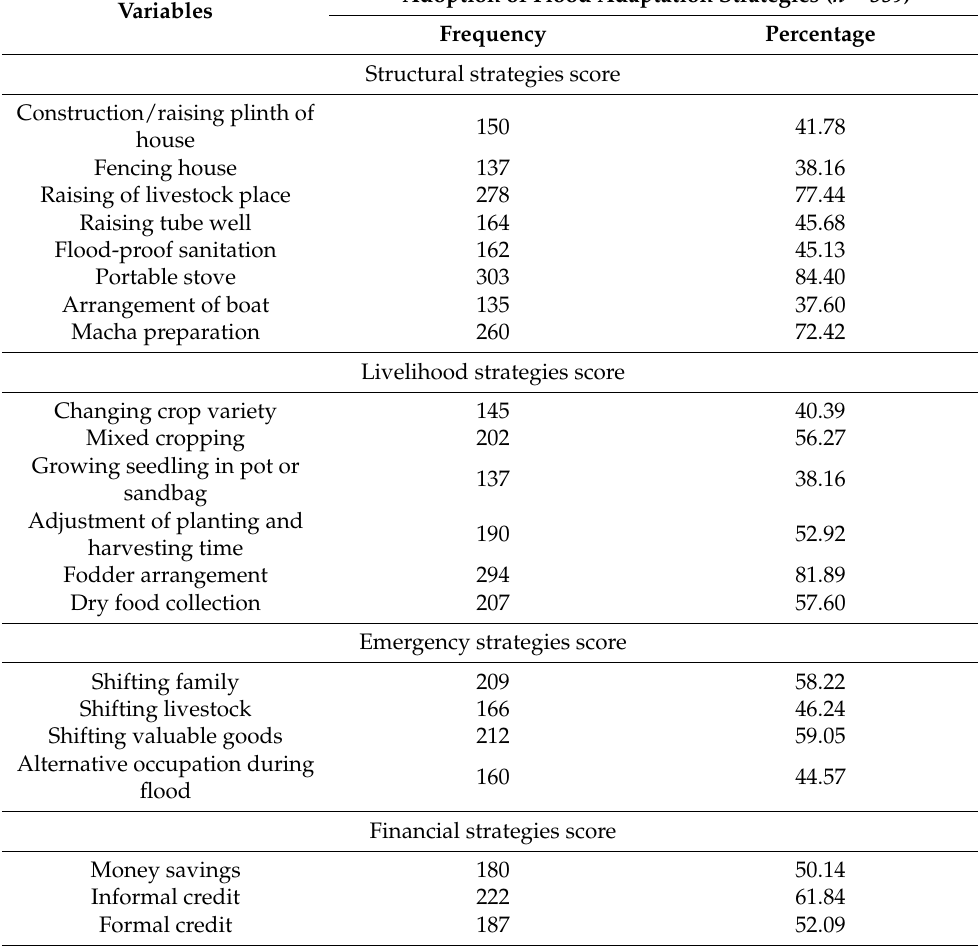
Table 3. Farmers’ adoption of flood adaptation